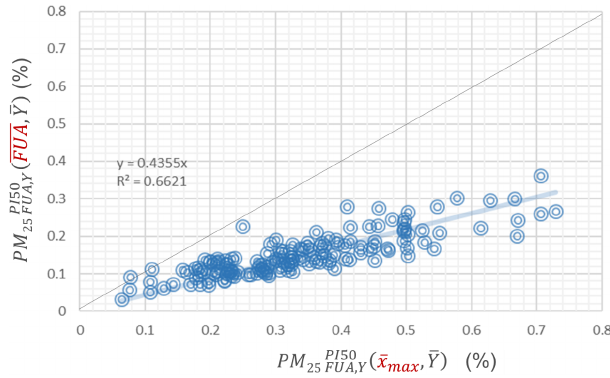
Figure 6. Comparison of potential impacts for 150 cities in Europe obtained for a receptor spatially defined as the location where the concentration is maximum in the city ( x max – x axis) and defined as the spatially averaged FUA (FUA). For these calculations, the source is defined as the FUA over which emissions are switched off during the whole year. The indicator is the total PM 2 . 5 mass. All results are based on the SHERPA-CHIMERE model using a potential impact SA method for a reduction strength of 50% (PI50) and are based on yearly averages at the receptor ( Y